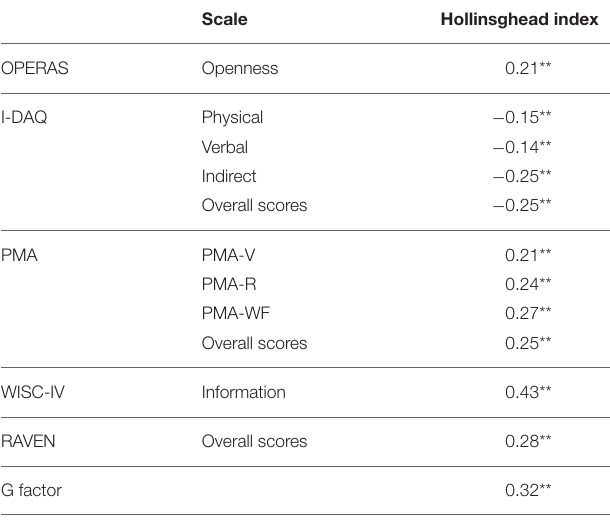
TABLE 1 | Significant correlations between socioeconomic level (Hollinsghead index) and variables of personality and capacity in the matched sample. Scale